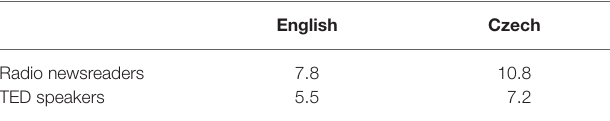
TABLE 1 | Mean length of prosodic phrases (in syllables) in English and Czech in news reading (Volín, 2019) and in TED speakers (this study; only major phrases with no disfluencies are